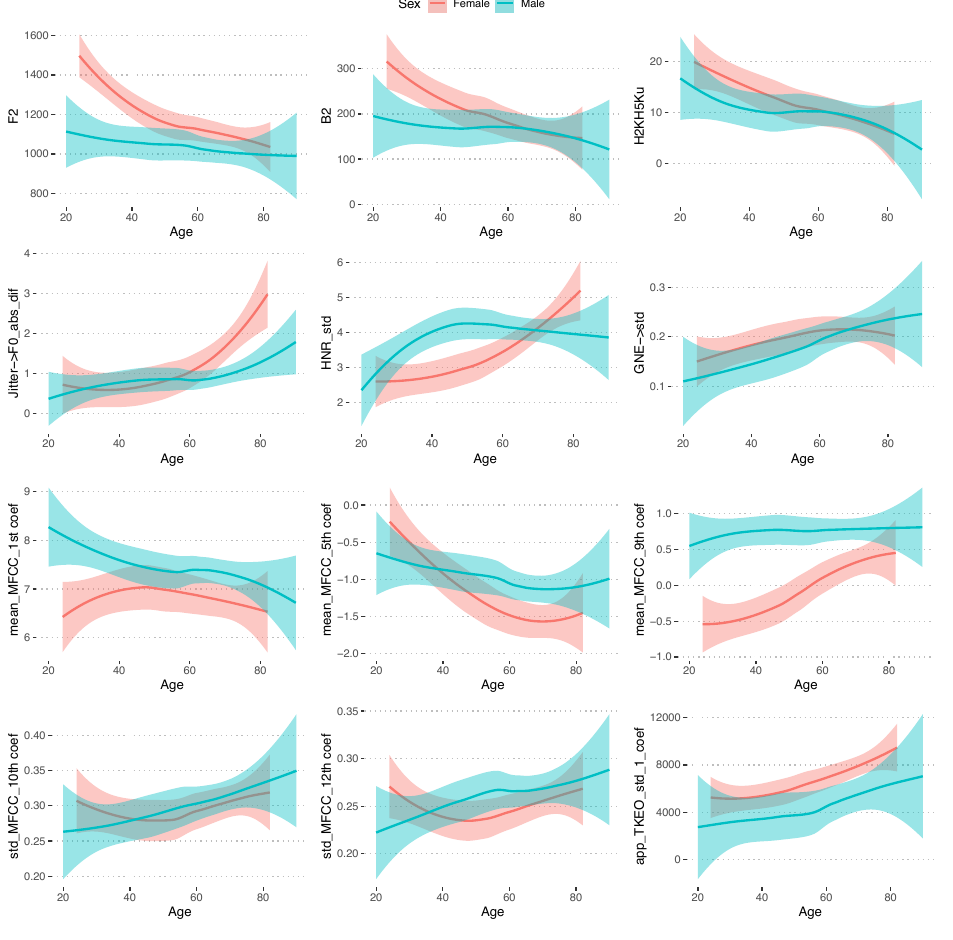
Figure 3. Errors in predicting a speakers’ age based on ( a ) the cross-validated model using acoustic measures of a sustained [a] as predictors, and ( b ) the cross-validated model in which DDK measures were used. The known age of the speaker is shown on the horizontal axis and the vertical axis shows the prediction error.